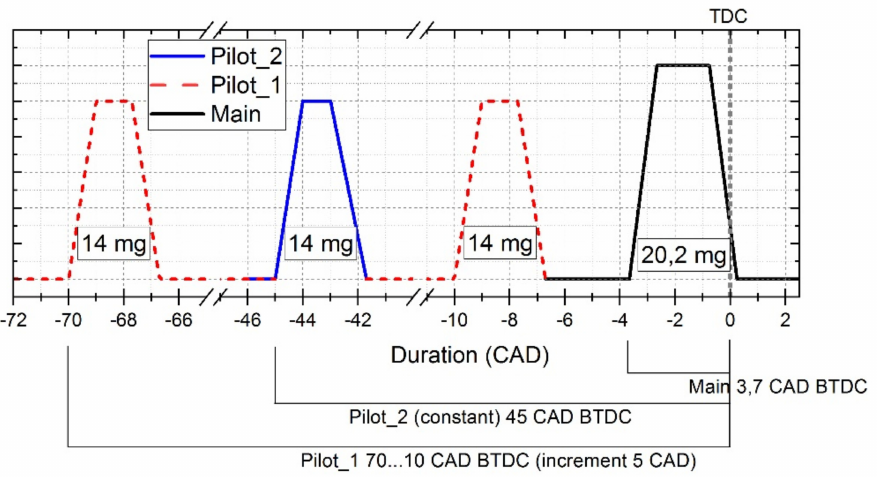
Figure 4. The injection strategy for the second pilot SOI 45 CAD